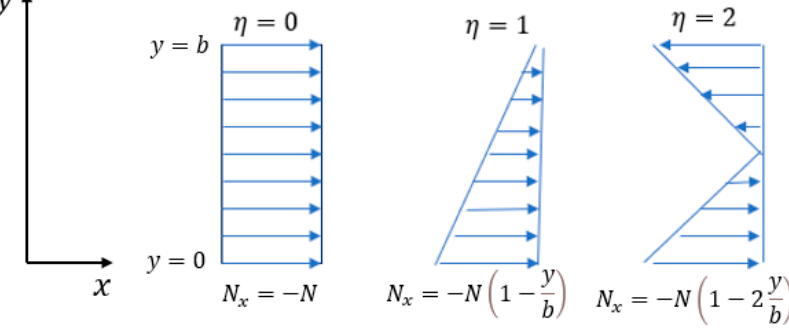
Figure 6. The stress distribution for different values of 𝜂 .